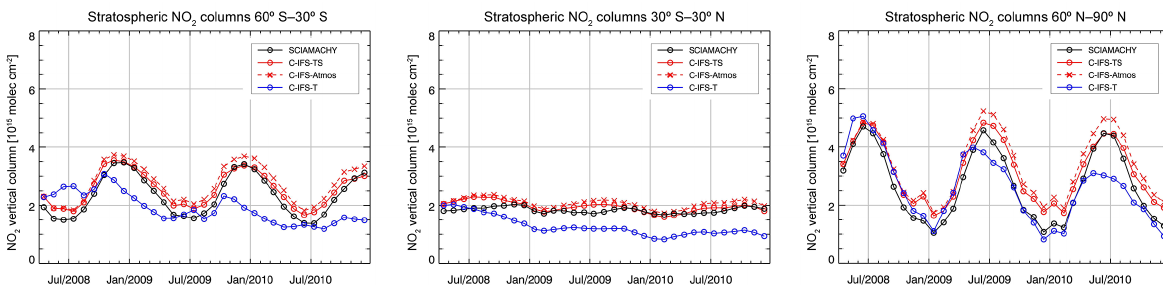
Figure 8. Time series of total column NO 2 above the clean Pacific Ocean (180–220 ◦ E) for April 2008–December 2010, in units 10 15 moleccm − 2 for NH mid-latitudes (left), tropics (middle) and SH mid-latitudes (right). Black: SCIAMACHY observations; red dashed: C-IFS-Atmos; red solid: C-IFS-TS; blue: